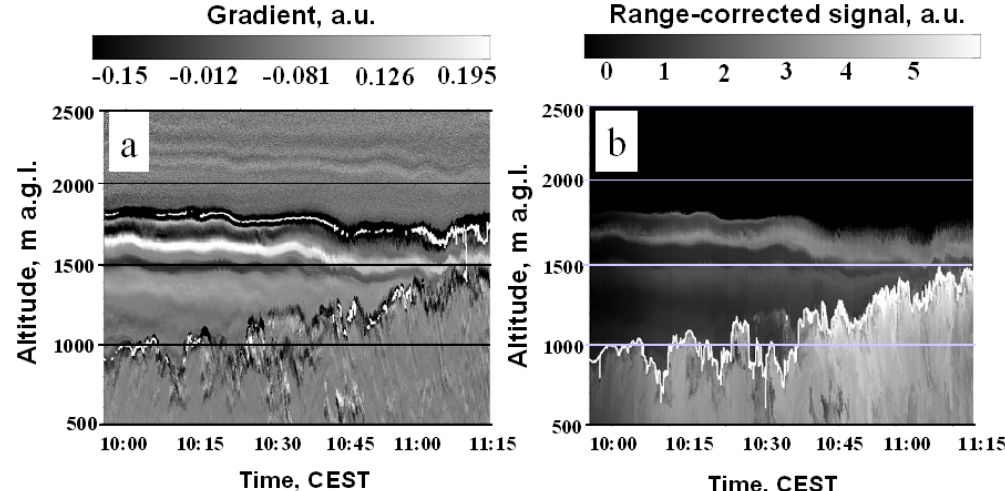
Fig. 5. Retrieval of z HWT in the presence of several aerosol layers in the CBL during Case II. The HWT has been applied in the altitude range of 500m to 3000m with a dilation value of 260m. (a) time-altitude-plot of D(z) . A broken white line marks the location of the maximum of W f (a,b). The HWT-based method mostly identifies erroneously the residual aerosol layer height as ABL top in this case. (b) HWT is applied in selected altitudes. The upper limit has been restricted to below the residual aerosol layer. Time series of CBL top z HWT (white solid line) superimposed on the range-square corrected lidar backscatter intensity. The convectively growing ABL top is identified correctly and is consistent with a strong gradient in the entrainment